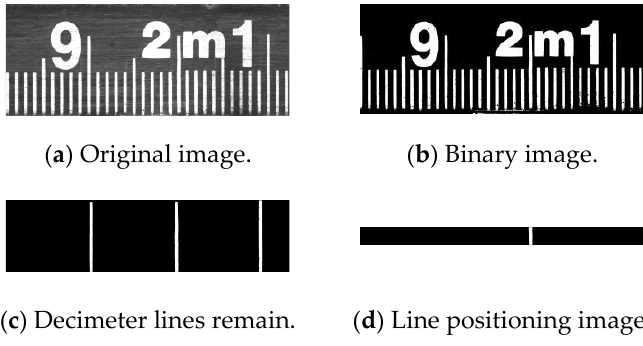
Figure 10. Identification closest to the starting line.